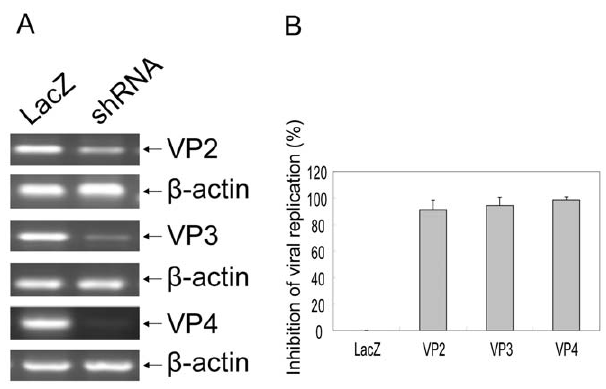
Figure 2. shRNAs targeting viral gene and inhibiting replica- tion of FMDV in BHK-21 cells. BHK-21 cells stable expressing shRNA were cultured in 12-well plates in four replicates, each well inoculated with 100 TCID 50 of the FMDV ASIA1/YS/CHA/05 strain. 48 hrs after FMDV inoculation, the cells and virus were collected, and mRNA expression of viral genes was determined by RT-PCR, b -actin as control (A), and FMDV viral replication was determined by TCID 50 (B). The results from three independent experiments in quadruplicate were presented as 1 minus a percentage of average TCID 50 in treated cells to that in LacZ shRNA expressed control cells 6 one standard deviation.